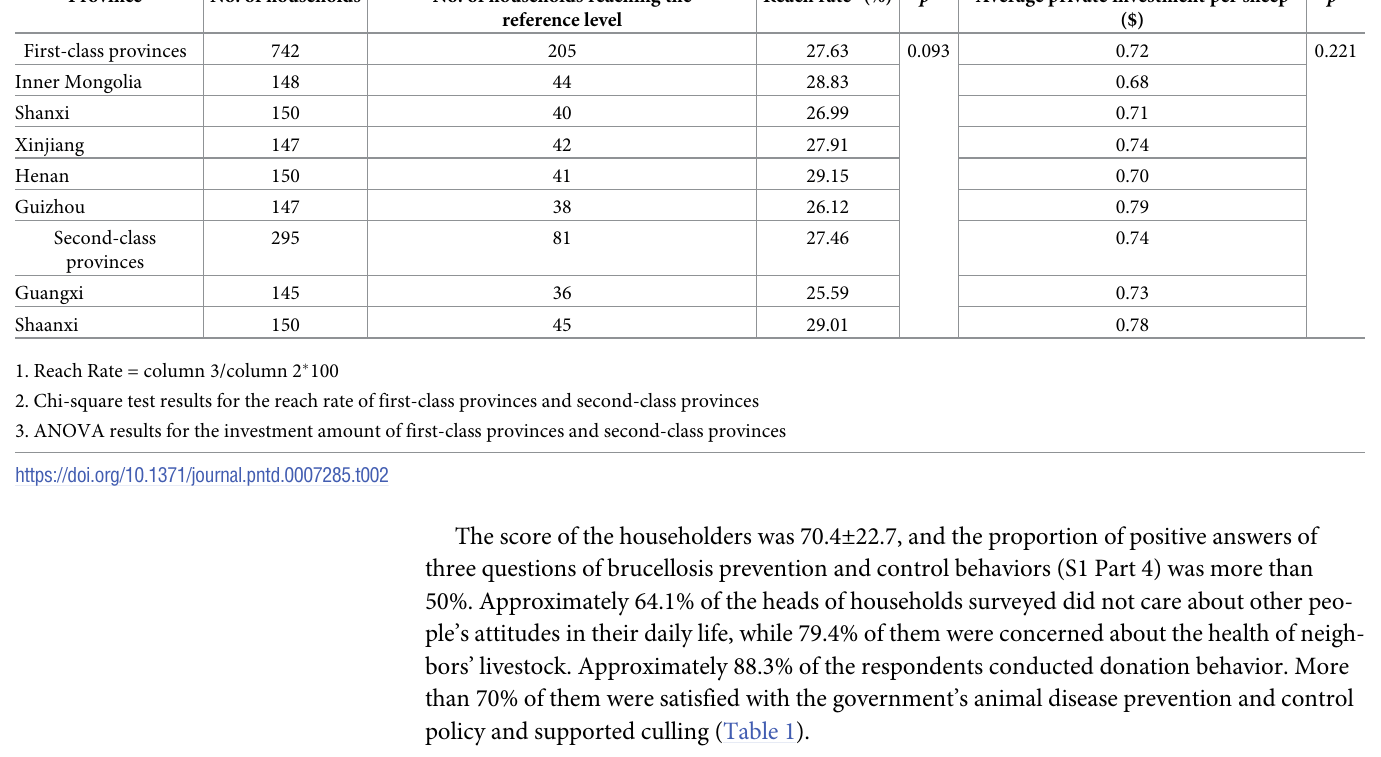
Table 2. The status of households’ private investment in the prevention and control of brucellosis in provinces of different classes. Province No. of